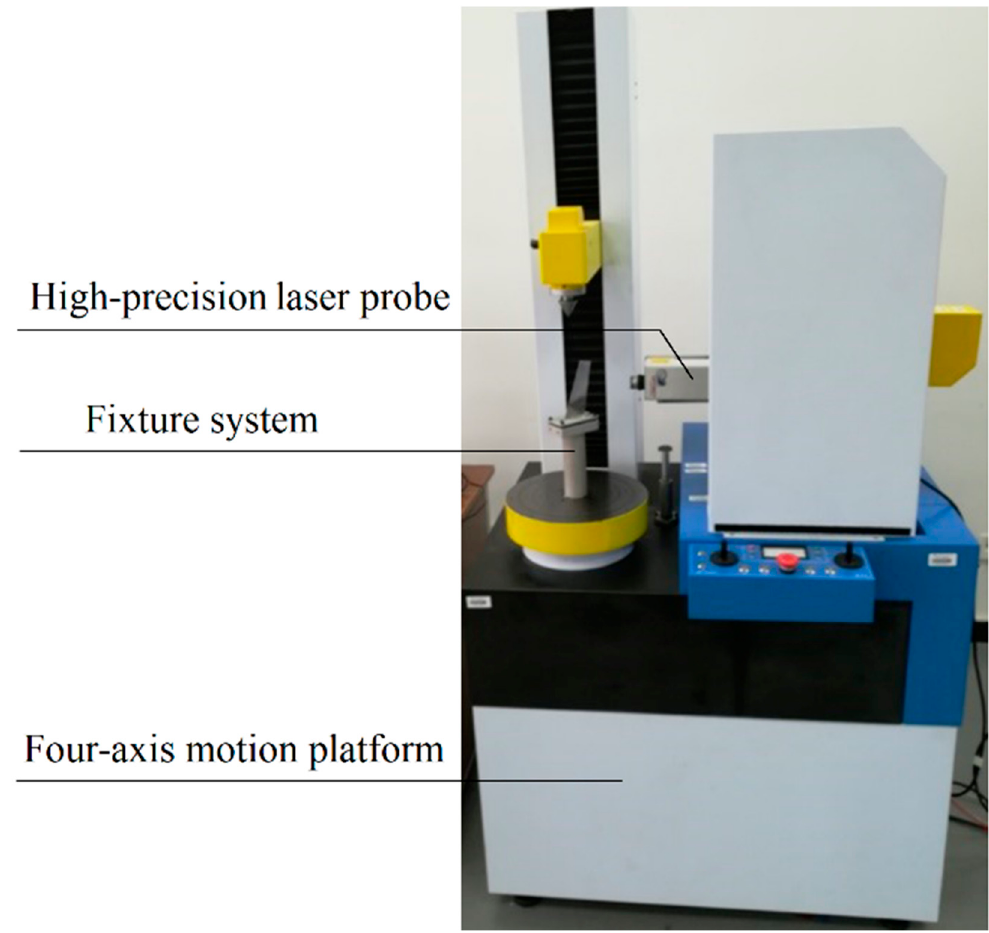
Figure 3. High-precision special machine for blade measurement.